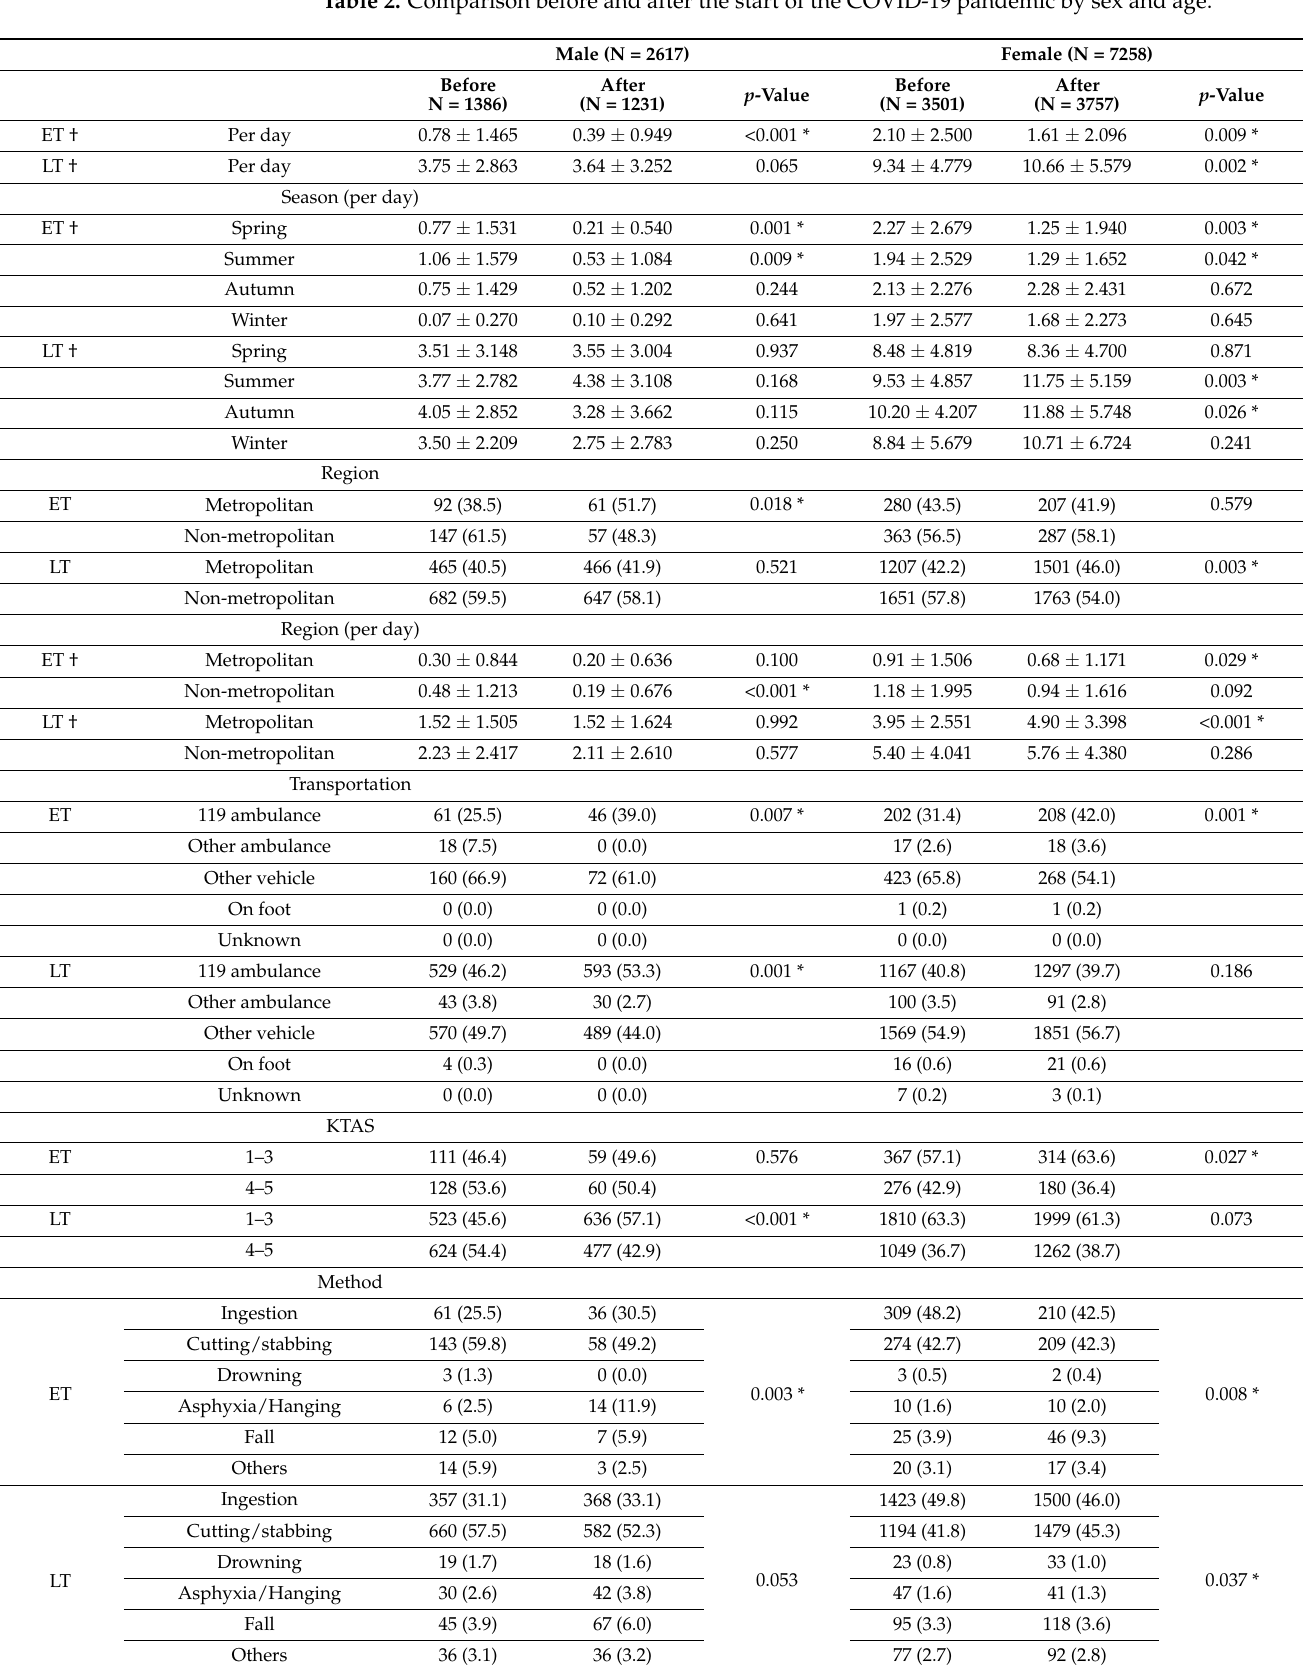
Table 2. Comparison before and after the start of the COVID-19 pandemic by sex and